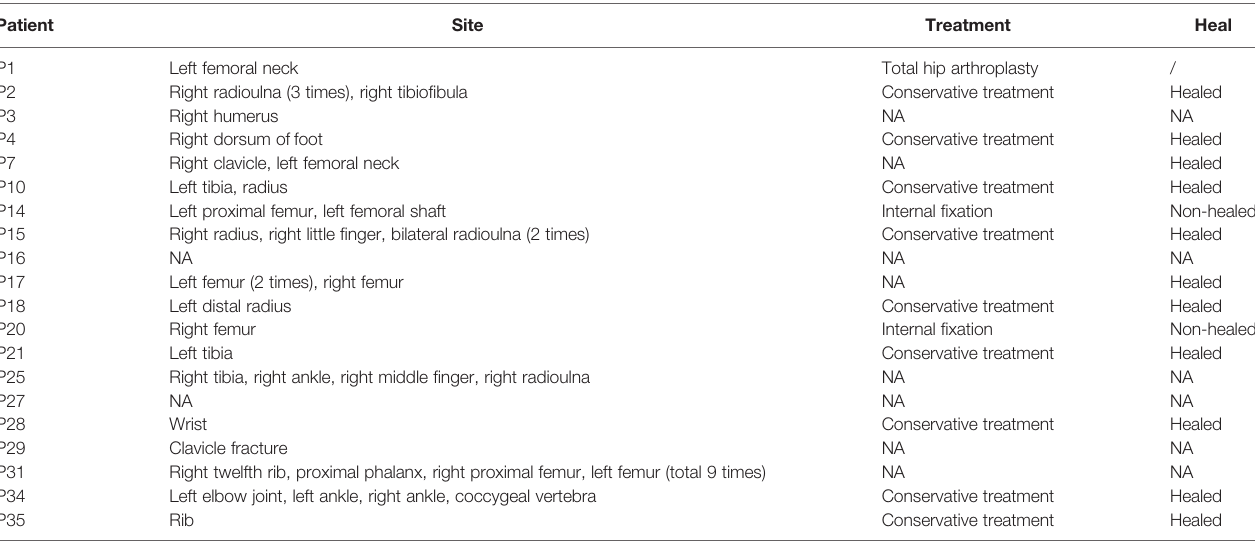
FIGURE 1 | Typical X-ray examinations of ADO II (A, B) A patient (P2) with classic radiograph fi ndings including diffuse osteosclerosis and the appearance of a rugger-jersey spine (black arrow). (C) A patient (P2) with a sclerotic skull, especially in the basis cranii (black arrow). (D) The typical appearance of “ bone within bone ” in the Patient 5 (black arrow). (E) A deformed tibia due to multiple fractures in the Patient 2(white arrow).